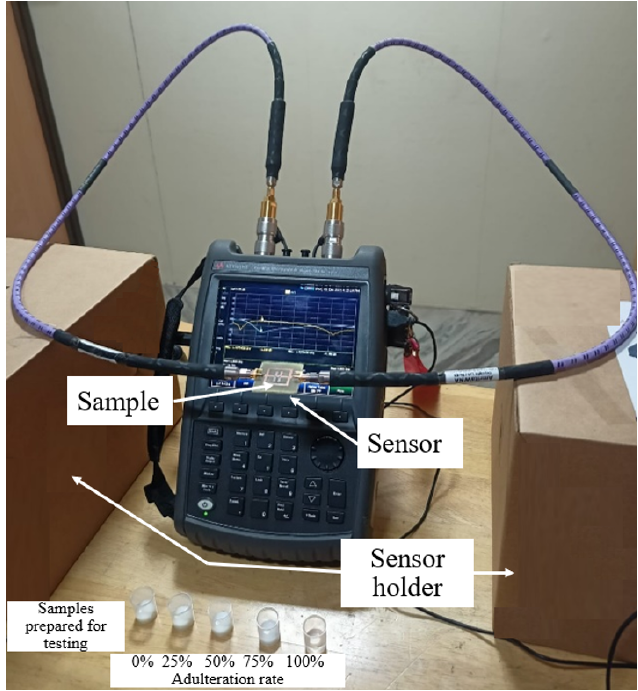
Figure 26. Experimental assessment, measurement setup for adulteration testing.